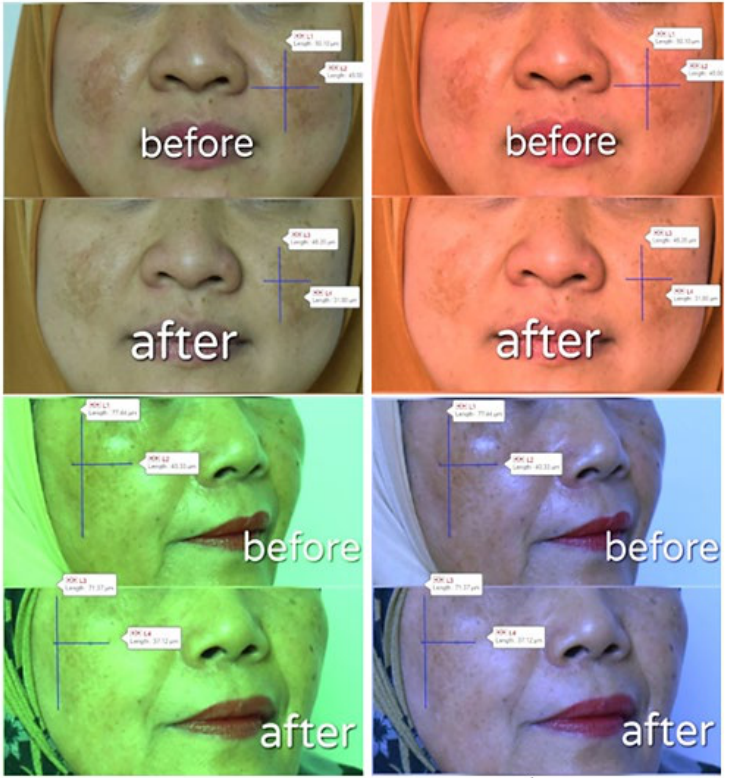
Figure 8. Analysis of length and width of spots’ area using Motic Live Imaging 3.0 with RGB.